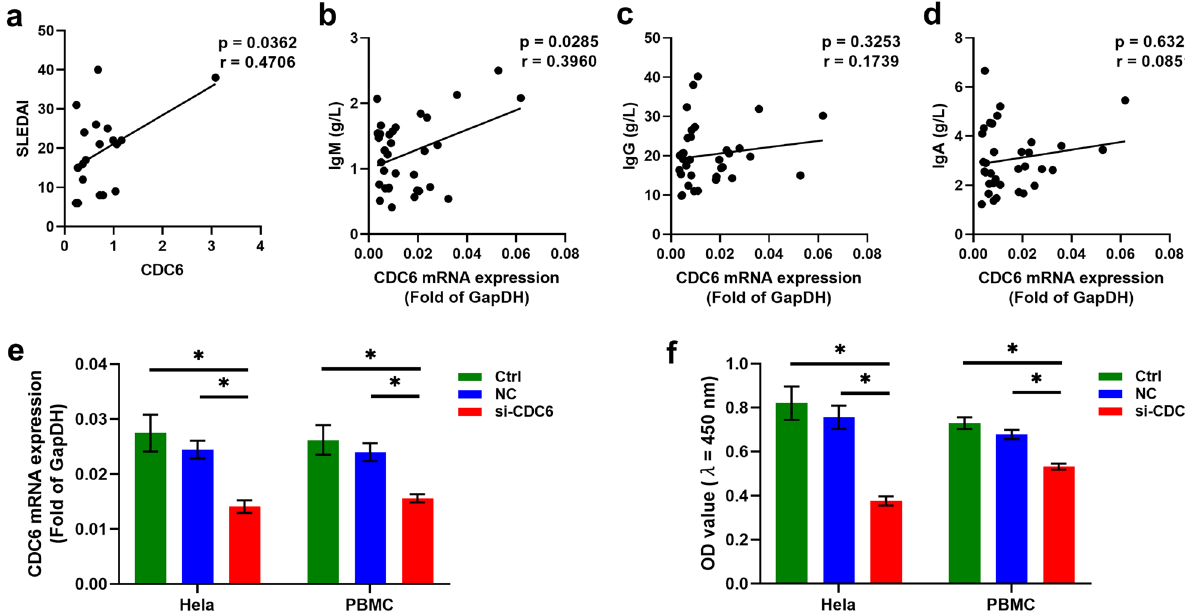
Figure 8. Analysis of the relationship between cell division cycle 6 ( CDC6 ) and SLE disease. (a) Correlations between the CDC6 levels and the SLEDAI of SLE patients. (b) Correlations between the CDC6 levels and the IgM levels in SLE patients. (c) Correlations between the CDC6 levels and the IgG levels in SLE patients. (d) Correlations between the CDC6 levels and the IgA levels in SLE patients. (e) CDC6 expression in Hela cells and SLE patients’ PBMCs was detected by Quantitative real-time PCR (qRT-PCR). (f) The effect of si- CDC6 on cell proliferation was analyzed by cell counting kit-8 (CCK-8) assay. * P <